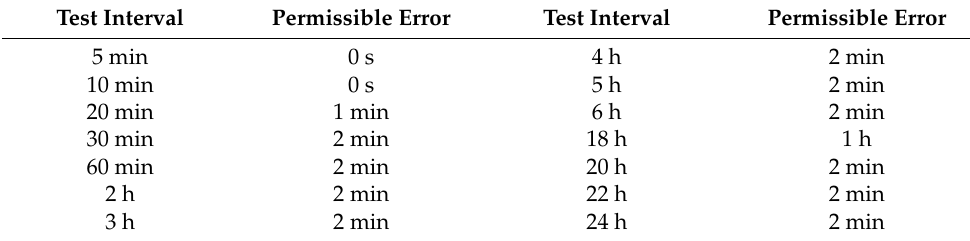
Figure 3. Capillary-water-absorption test flow chart. Table 7. Test time intervals and allowable errors.